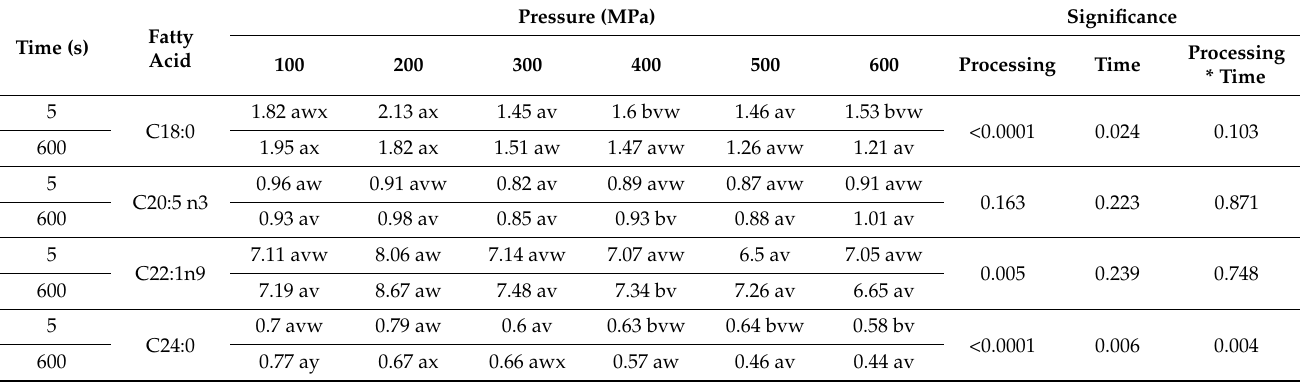
Table 6. Fatty acid composition of Tua Tua ( Paphies donacina ) clam. a,b means with different letters within a row show the significant effect of time at each processing pressure; v,w,x,y,z means with different letters within column show the significant effect of time under the same processing pressure. * Compounds identified with VID coefficients higher than